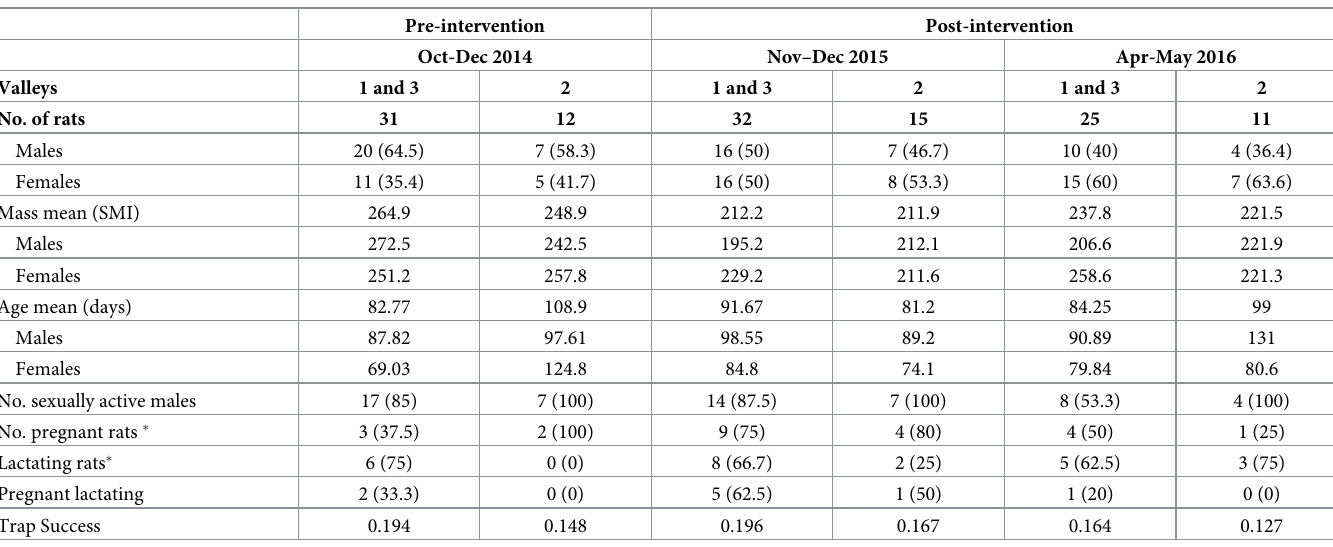
Table 2. Summary of population characteristics of R . norvegicus before and after chemical intervention in Pau da Lima, Salvador,